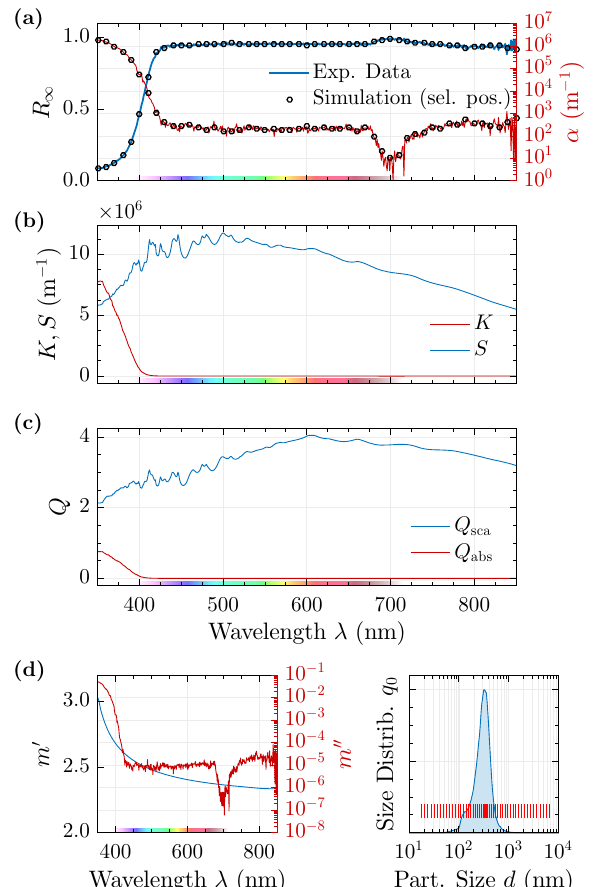
Figure 16. Calculation steps as outlined in Figure 14. ( a ) Measured diffuse reflectance spectrum R ∞ ( λ ) (blue) and calculated values (circles) and the derived absorption coefficient α (red line); for better visibility, simulated values are shown only for selected positions; full calculations take the entire experimental dataset into account. The absorption-dip at 700nm results from experimental artifacts that is discussed in Section 3.2. ( b ) Kubelka–Munk absorption and scattering coefficient K and S from which R ∞ is calculated according to Equation (9). ( c ) Microscopic scattering and absorption efficiencies Q sca and Q abs calculated from Mie theory [154] used for deriving K and S . ( d ) Complex-valued refractive index (left); the real part is adapted from ref. [161] whereas the imaginary part is calculated from the experimental diffuse reflectance. The used size distribution q 0 ( d ) with sampled sizes d i is shown to the